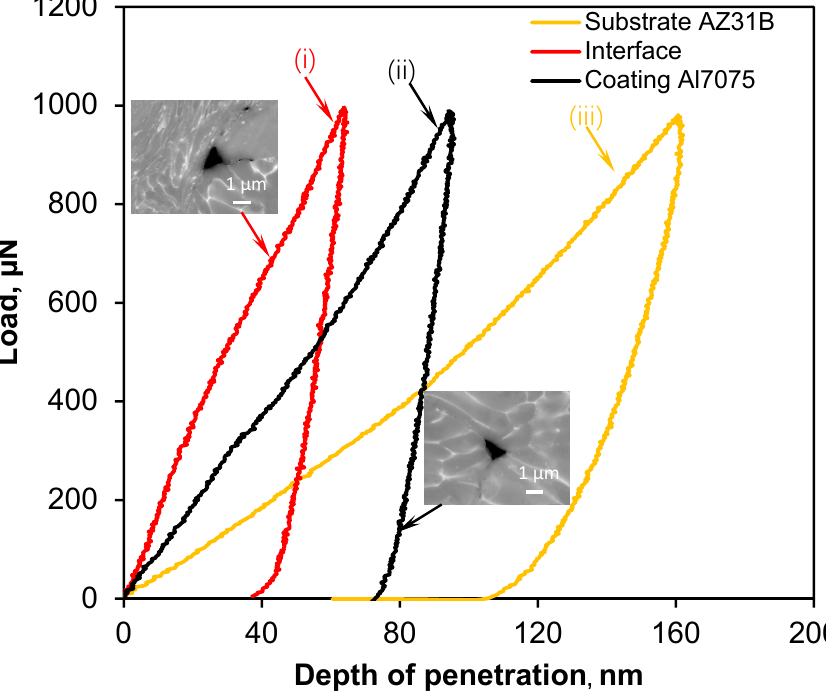
Figure 5. Typical loading–unloading curves obtained during nanoindentation at a load of 1 mN for (i) AA7075 CS coating, (ii) near the interface of AA7075 coating, and (iii) AZ31B substrate, with the corresponding SEM images of indent on the coating and near the interface.